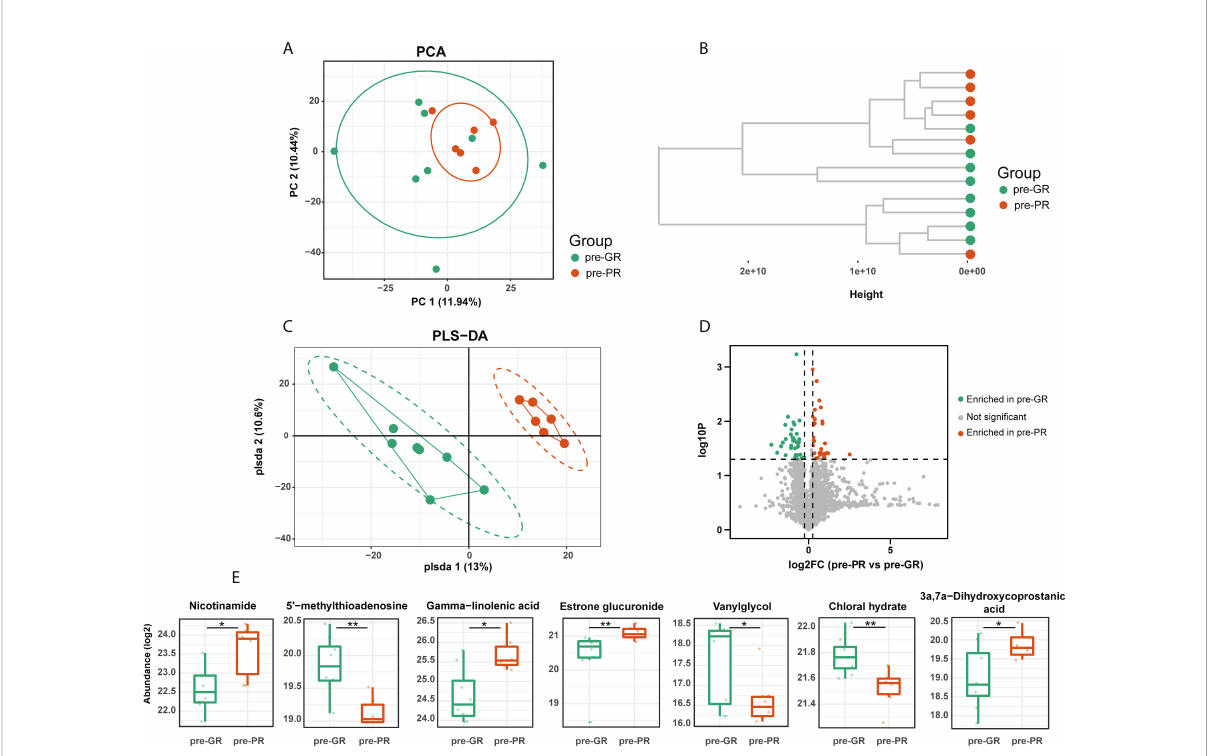
FIGURE 2 The baseline of serum metabolome comparison between different MTX response groups. (A) PCA, (B) hierarchical clustering, and (C) PLS-DA results describing the dispersing trends of the metabolome pro fi le. (D) Volcano plot for differential metabolites between pre-GR and pre-PR. (E) Representative differential metabolites involved in the corresponding pathway. Signi fi cance is determined by using VIP of PLS-DA > 1, combined with |log2FC| ≥ 0.25 and Student ’ s t -test p -value < 0.05. *Student ’ s t -test p < 0.05; **Student ’ s t -test p <